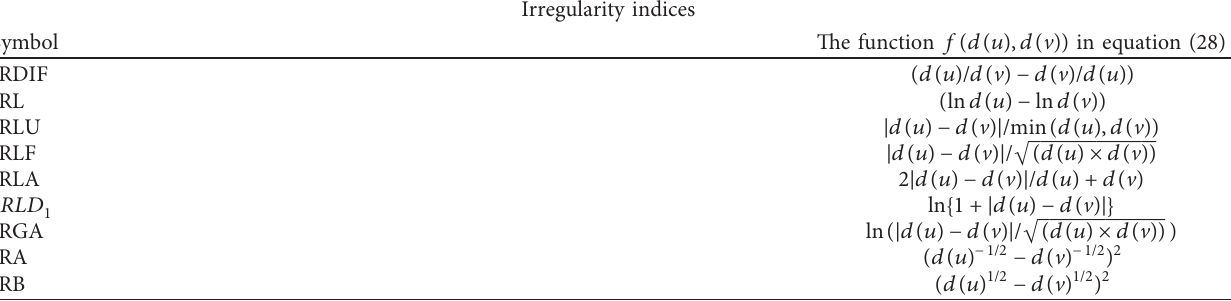
Table 1: Some irregularity indices considered in